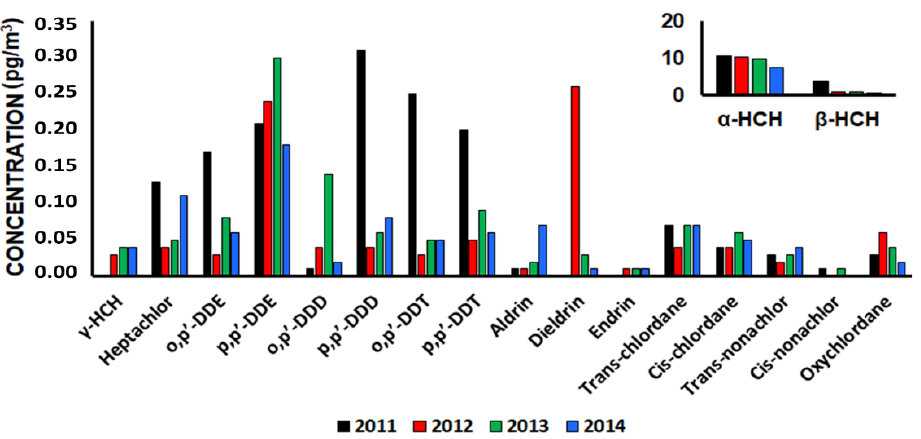
Figure 2. Pollution profile of OCP congeners between 2011 and 2014 in the air of the Antarctic region (Wang et al. 2018) [60].